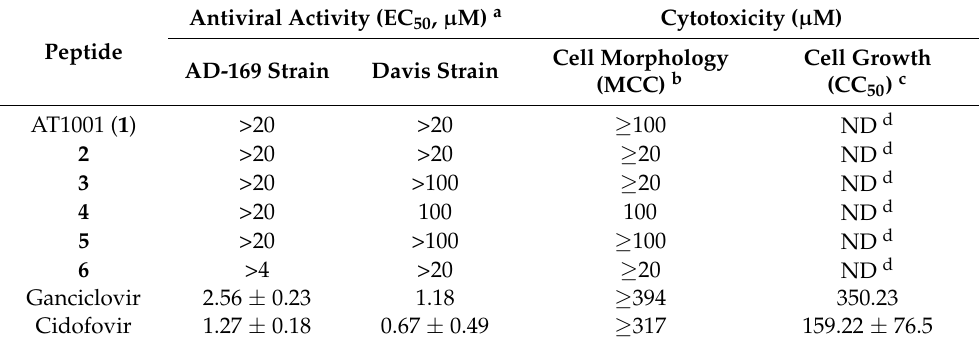
Table 2. Activity of the synthesized peptides against cytomegalovirus (HCMV) in human embryonic lung (HEL) cells.